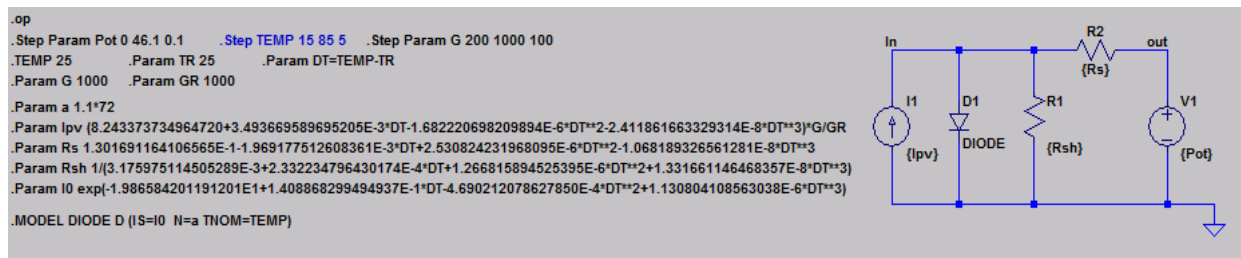
Figure 5. Equivalent circuit of MSMD290AS-36.EU (monocrystalline).